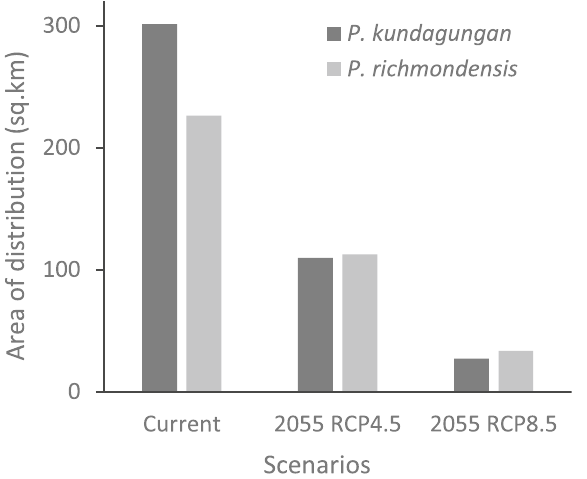
Figure 1. Area (sq. km) of the predicted distribution of P. kundagungan and P. richmondensis under current and future climate scenarios.